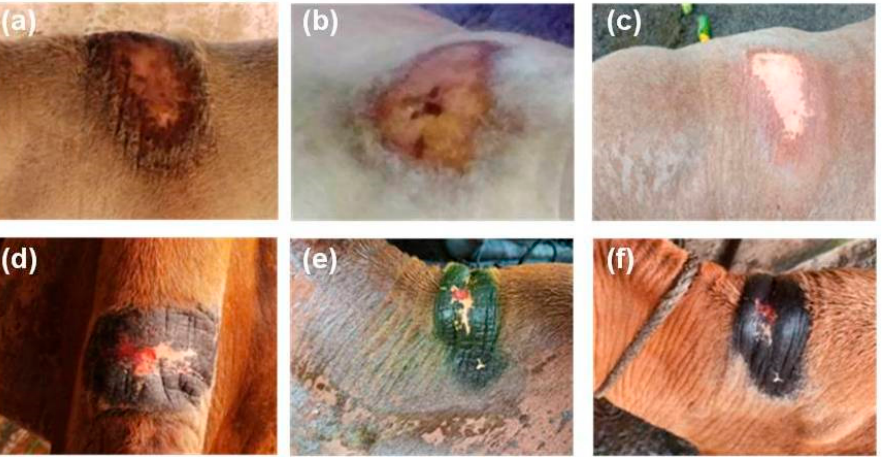
Figure 3. Effect of tri-model therapy on humpsore lesions, ( a , d ) Animals before treatment, ( b , e ) 15 days post-treatment, ( c , f ) 30 days post-treatment.